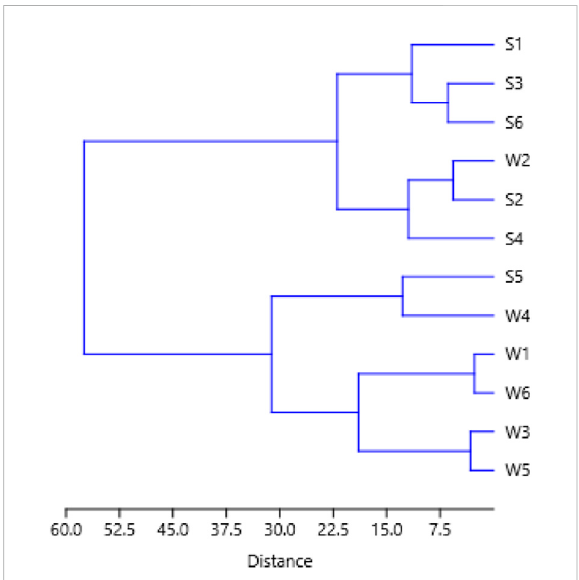
FIGURE 6 Dendrogram based on the Ward ’ s method for the 6 winter (W) and 6 spring-summer (S) samples. The input variables are the Ca, Fe, S, and Zn concentrations determined by PIXE using both PTFE(P)andquartz(Q) fi lters,inadditiontothestableisotope measurements of nitrogen and carbon ( δ 15 N and δ 13 C, respectively), particulate nitrogen and carbon content (PN and PC, respectively), amount of 14 Cexpressedinaunitof percent modern carbon (pMC), and the contemporary carbon fraction f c